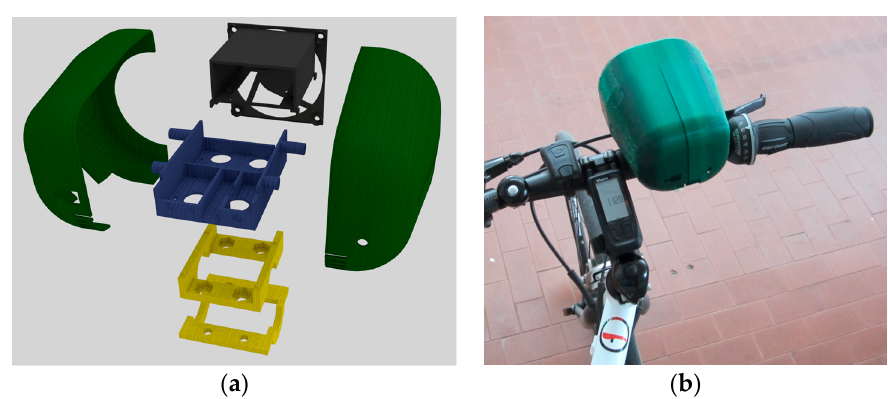
Figure 1. Monitoring system: ( a ) assembly scheme rendering; ( b ) as